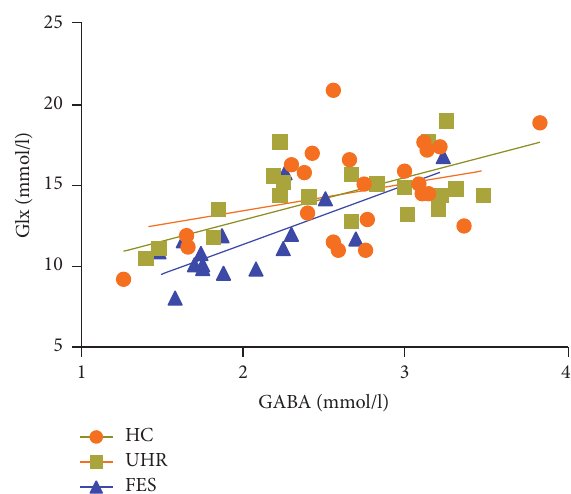
Figure 3: Scatter plots with linear regression fit for the relation- ship between GABA and glutamate+glutamine (Glx) levels among patients with first-episode schizophrenia (FES, 𝑟 = 0.79 , 𝑃 < 0.001 ), subjects at ultrahigh risk for psychosis (UHR, 𝑟 = 0.56 , 𝑃 = 0.008 ), and healthy controls (HC, 𝑟 = 0.53 , 𝑃 = 0.009